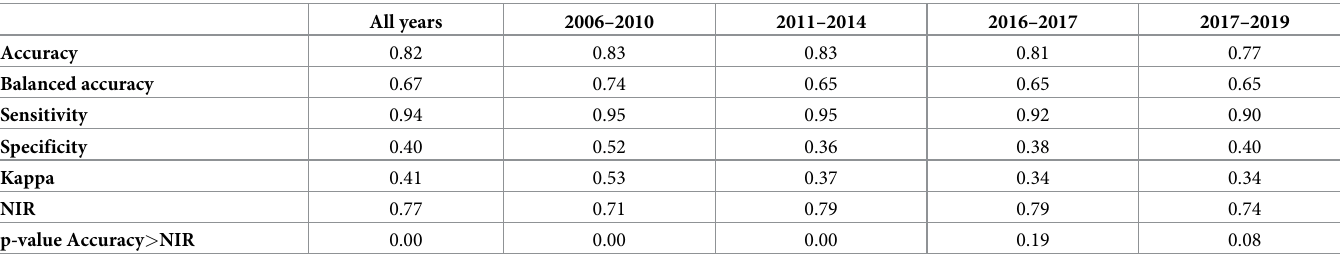
Table 4. Accuracy measures from out-of-sample test data for final random forest